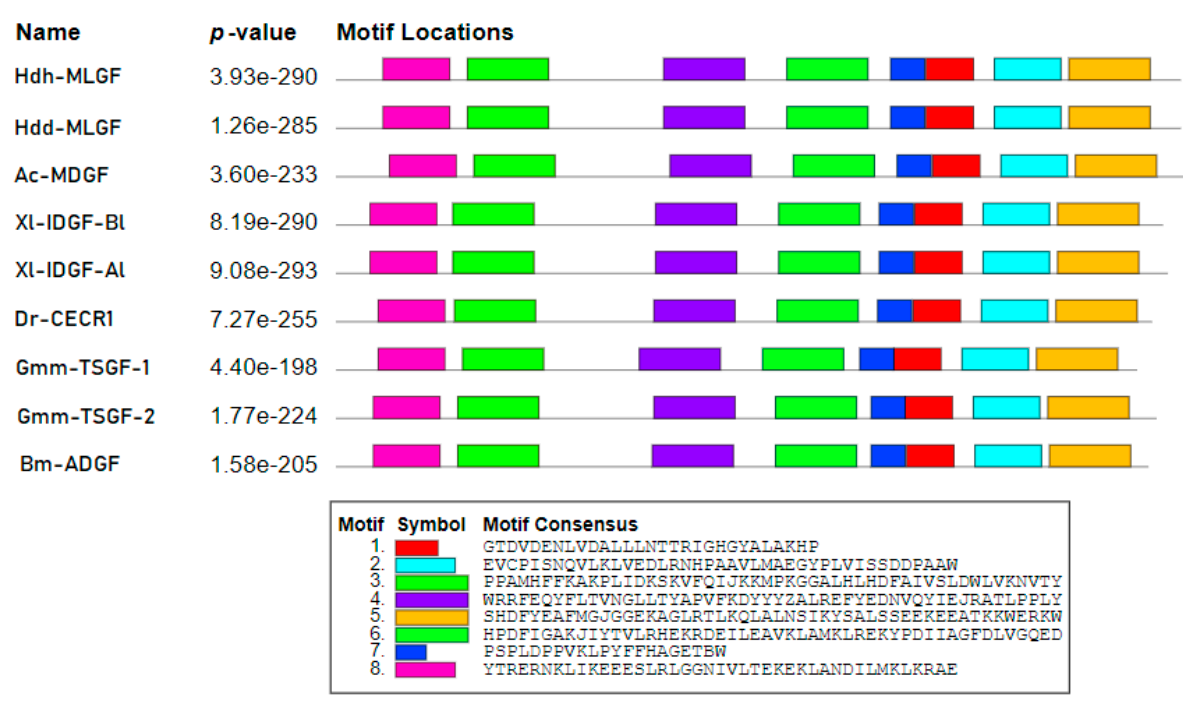
Figure 2. Schematic diagram of detected motifs in the Hdh-MLGF protein sequence and other ADGF subfamily members of vertebrates and invertebrates. Detected motifs are explained by different colors. The motif analysis included the Hdh-MLGF amino acid sequence and other growth factors of the following ADGF family members: MLGF of H. discus (ABO26607.1), MDGF of Aplysia californica (AAD13112.1), IDGF-Al of Xenopus laevis (AAY42596.1), IDGF-Bl of Xenopus laevis